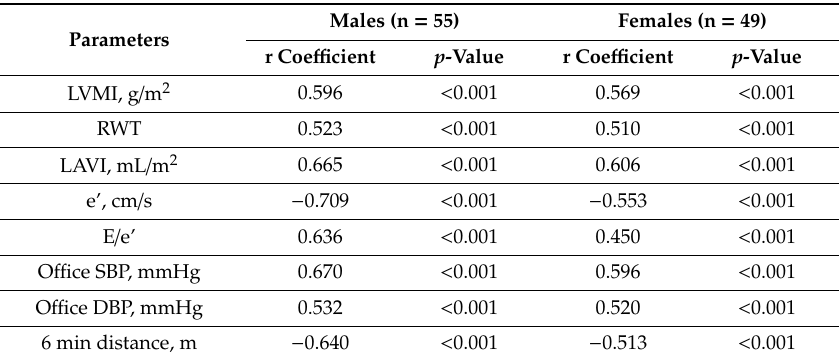
Table 4. Significant correlative relationships of tumor necrosis factor alpha level with other laboratory and instrumental indicators of cardiovascular prognosis in males and females with hypertension, complicated by CHF with preserved left ventricle ejection fraction.